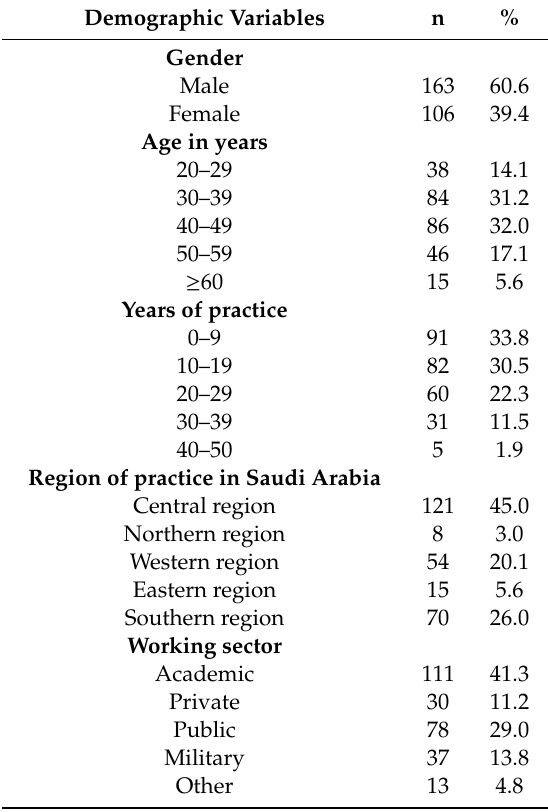
Table 1. Demographic data for participants.